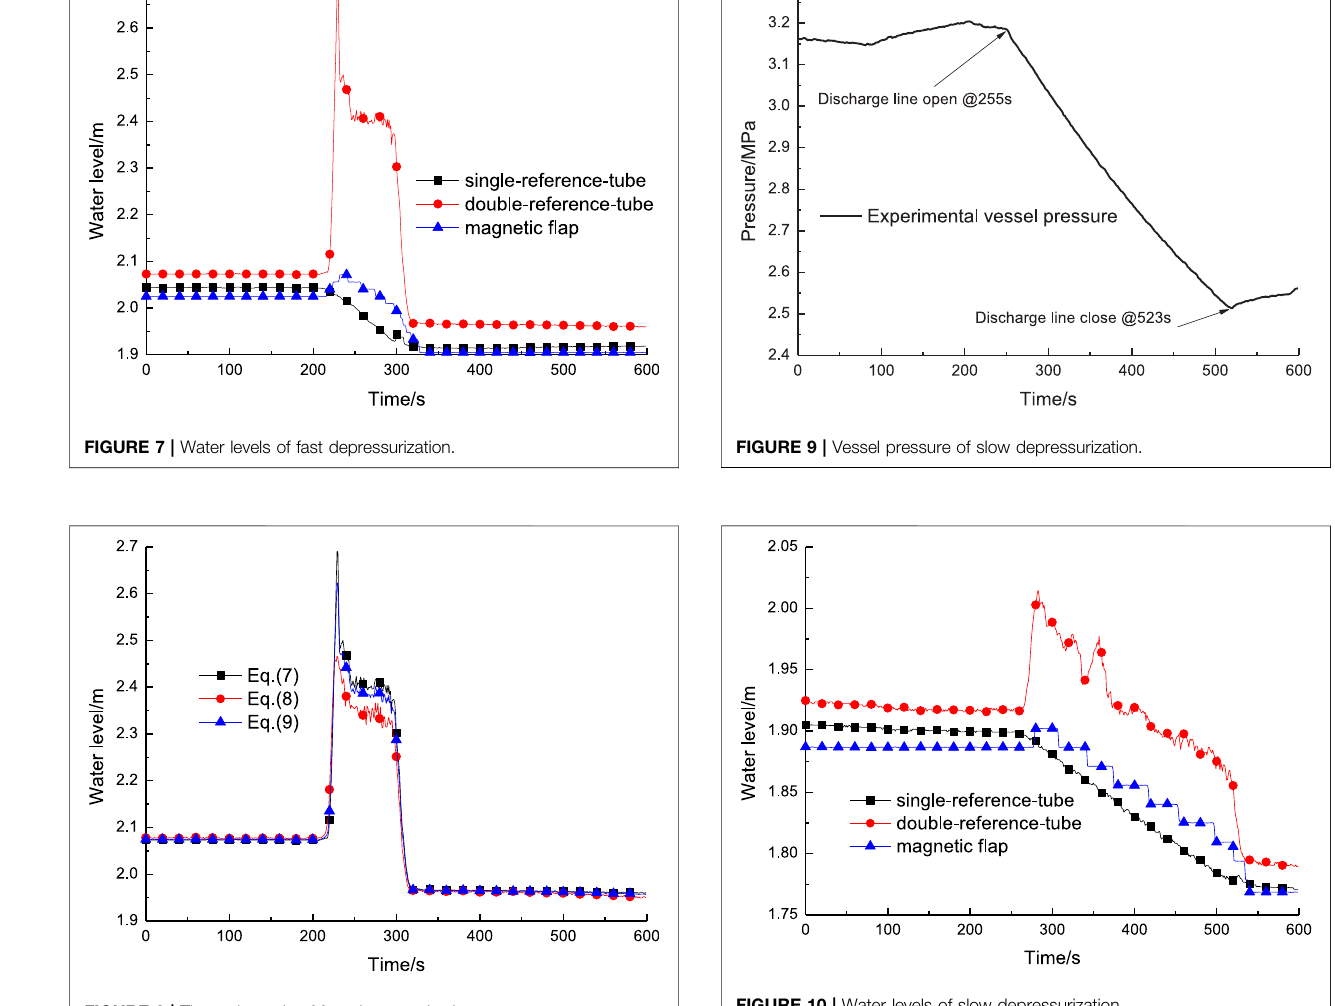
steam discharge line is opened at 255 s and closed at 523 s with